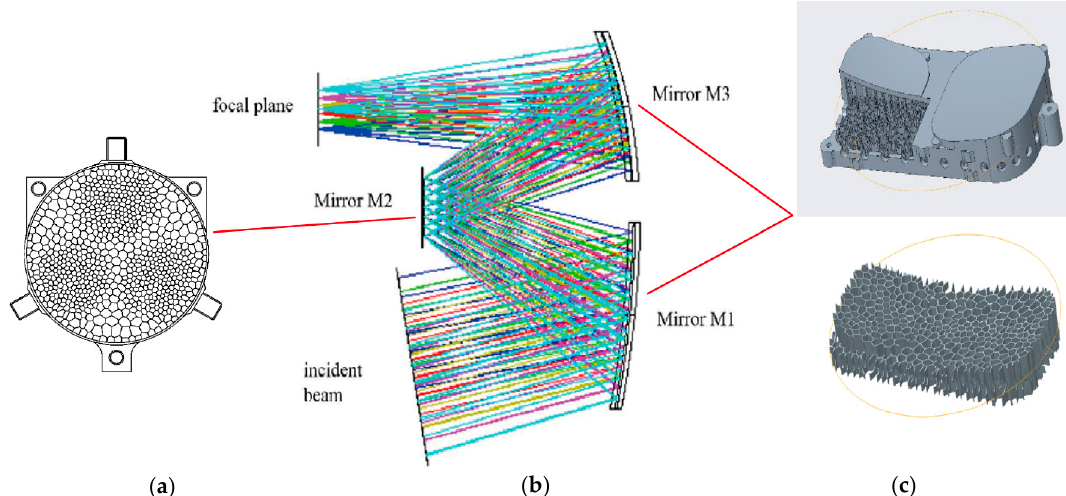
Figure 29. ( a ) Structure model of the secondary mirror; ( b ) Optical Design of the TMA; ( c ) The whole mirror model of the primary mirror and the third mirror [34,46,76].